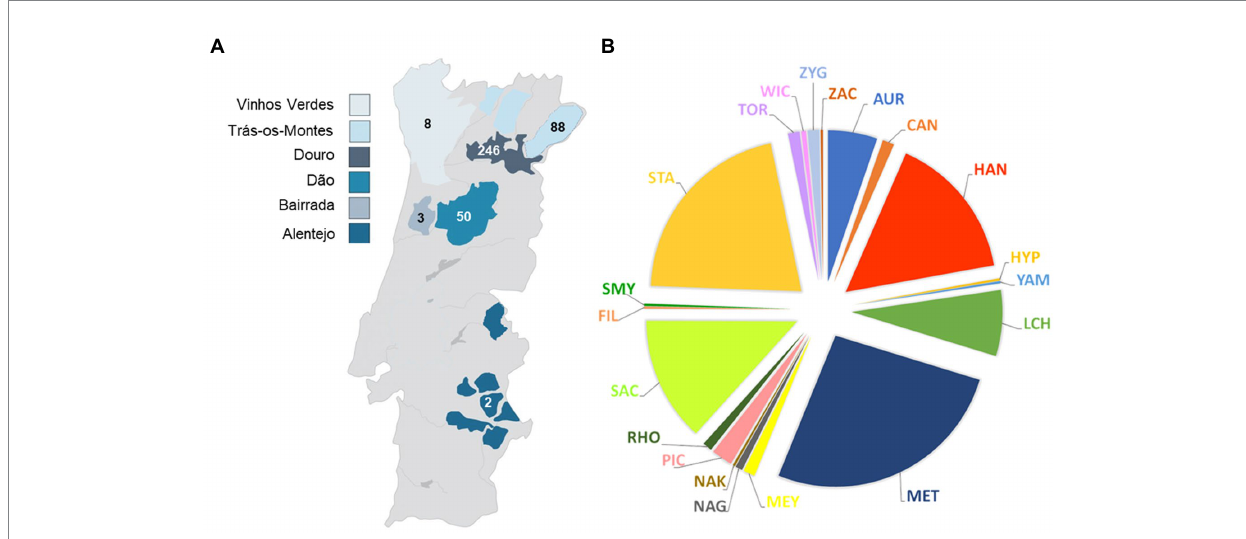
FIGURE 1 Geographical (A) and taxonomic distribution at the genus level (B) of the isolates examined in this study. The numbers of yeast isolates from the different wine regions are indicated and the colors represent the different genera. AUR, Aureobasidium ; CAN, Candida ; HAN, Hanseniaspora ;